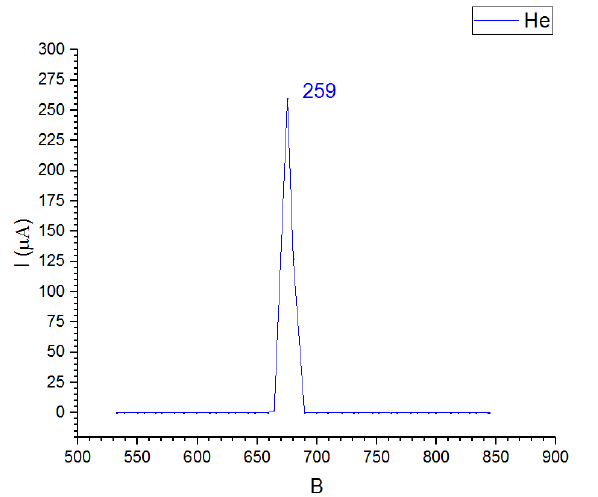
Fig. 5. Spectrum of helium ions at 2450 MHz, 60 W and Ø2 mm extraction hole.